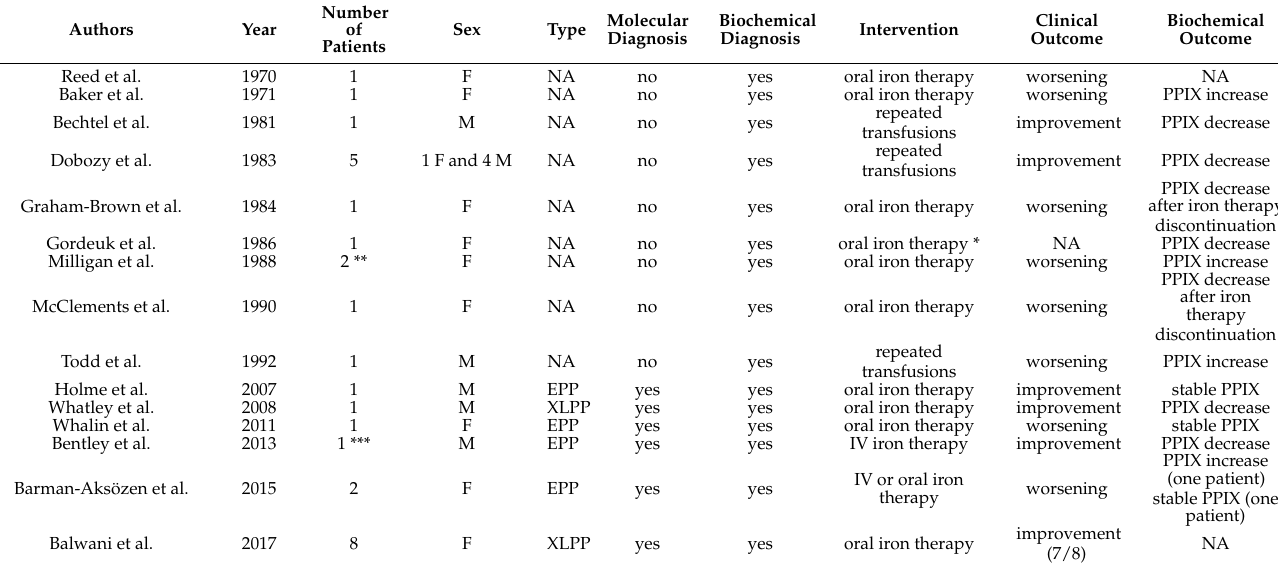
Table 1. Patients with erythropoietic protoporphyria treated with